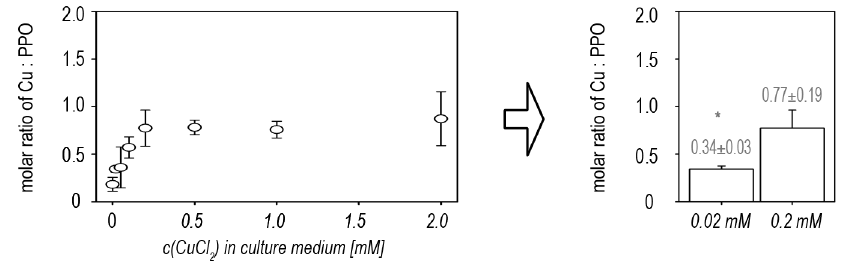
Figure 8. Copper-saturation of recombinant ToPPO-2. The copper content in aliquots containing defined amounts of purified ToPPO was determined using TXRF. Subsequently the molar ratio of Cu to purified PPO was calculated. * P , 0.01 in Student’s t-test (n=4).